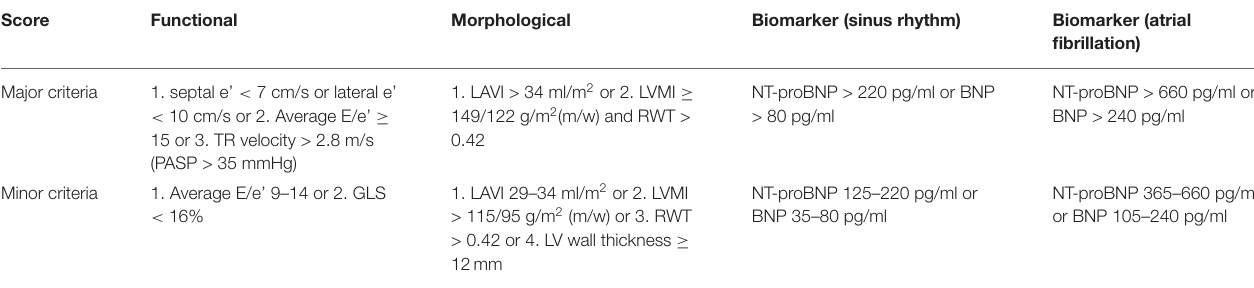
TABLE 1 | Echocardiography and natriuretic peptides scoring system.